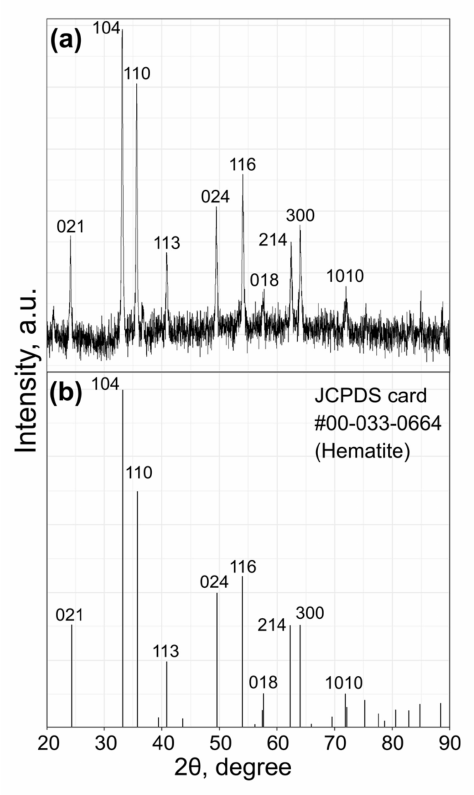
Figure 1. ( a ) The X-ray di ff raction patterns of the synthesized nanoparticles; ( b ) The reference patterns.